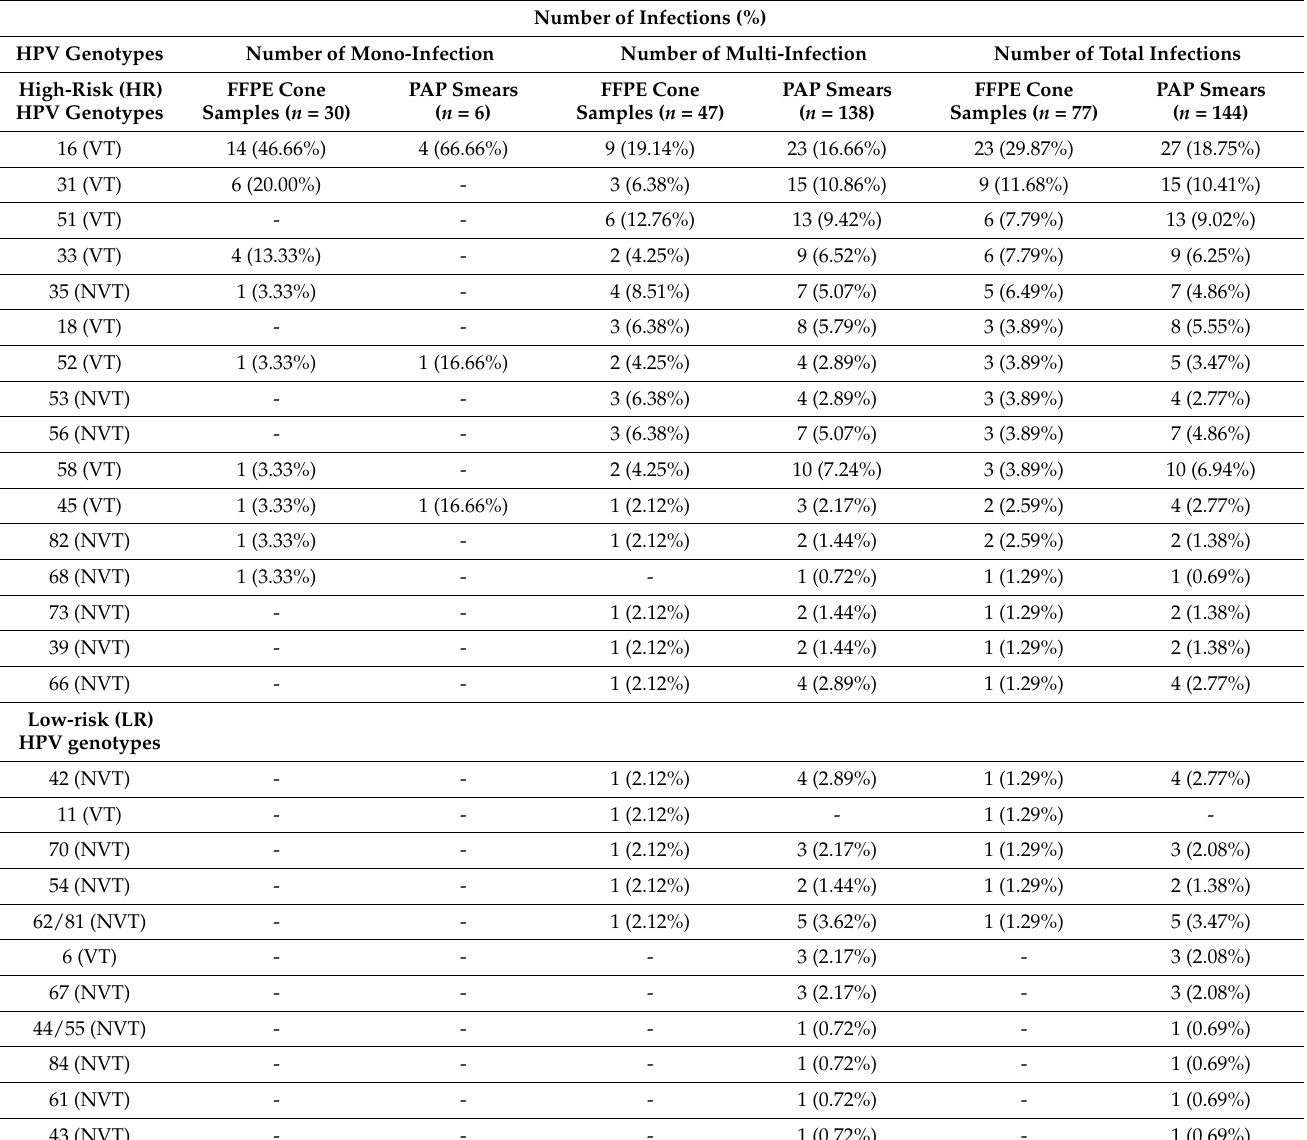
Table 1. Prevalence of human papillomavirus (HPV) genotypes and infection numbers in FFPE cone samples and PAP smears among patients diagnosed with high-grade squamous intraepithelial lesions (HSIL). VT: nonavalent vaccinated type HPV; NVT: non-nonavalent vaccinated type